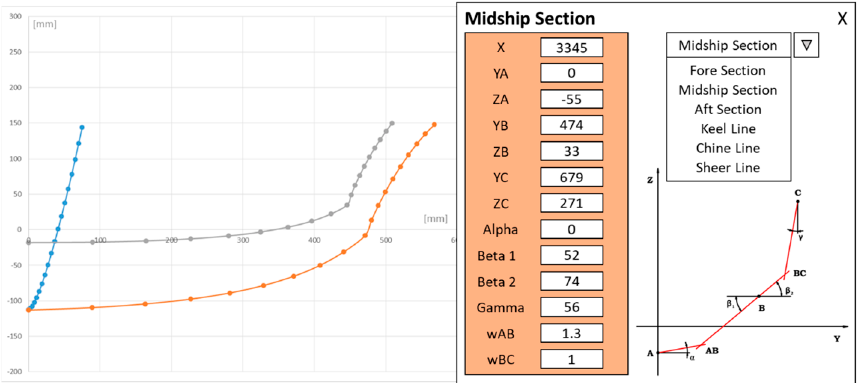
Figure 7. User-interface of a section.